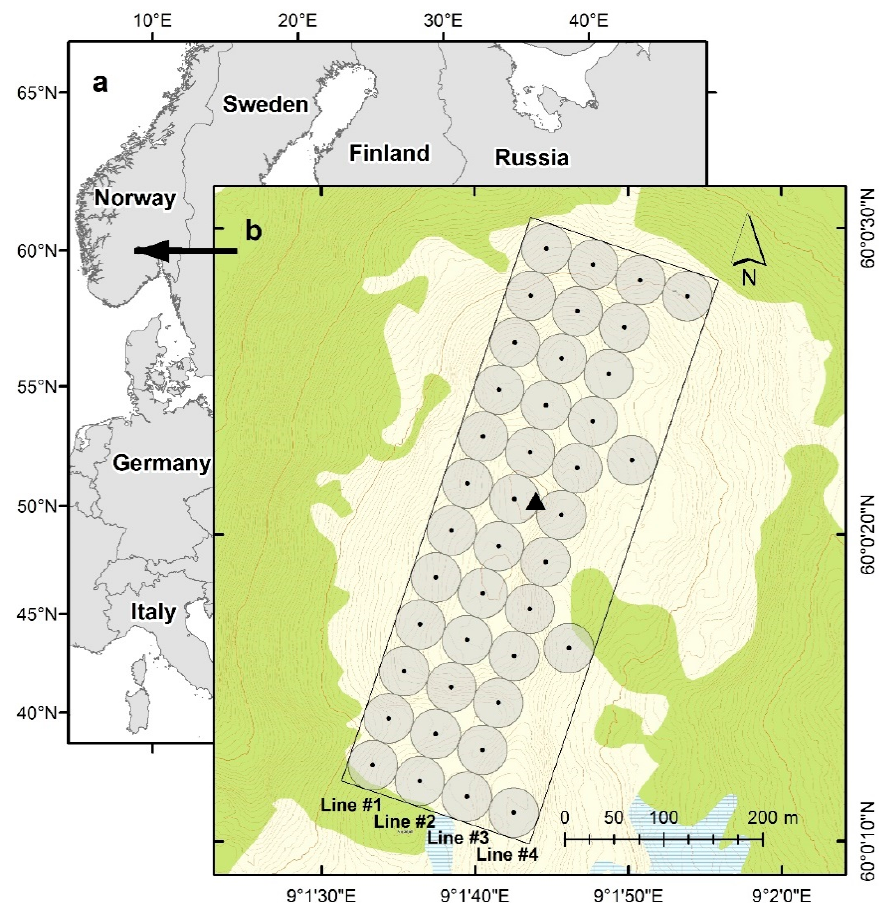
Figure 2. ( a ) Location of the study area and ( b ) design of the trial. The black dots are the point-centered quarter sampling points, which were centers of the 25 m radius plots (gray circles) arranged along four sample lines; green is defined as forest according to the official N50 topographic map series; light yellow is above the tree line; the black triangle is the reference point (base station). Table 1. Summary of field measurements of 316 trees measured in both 2006 and 2012. Tree